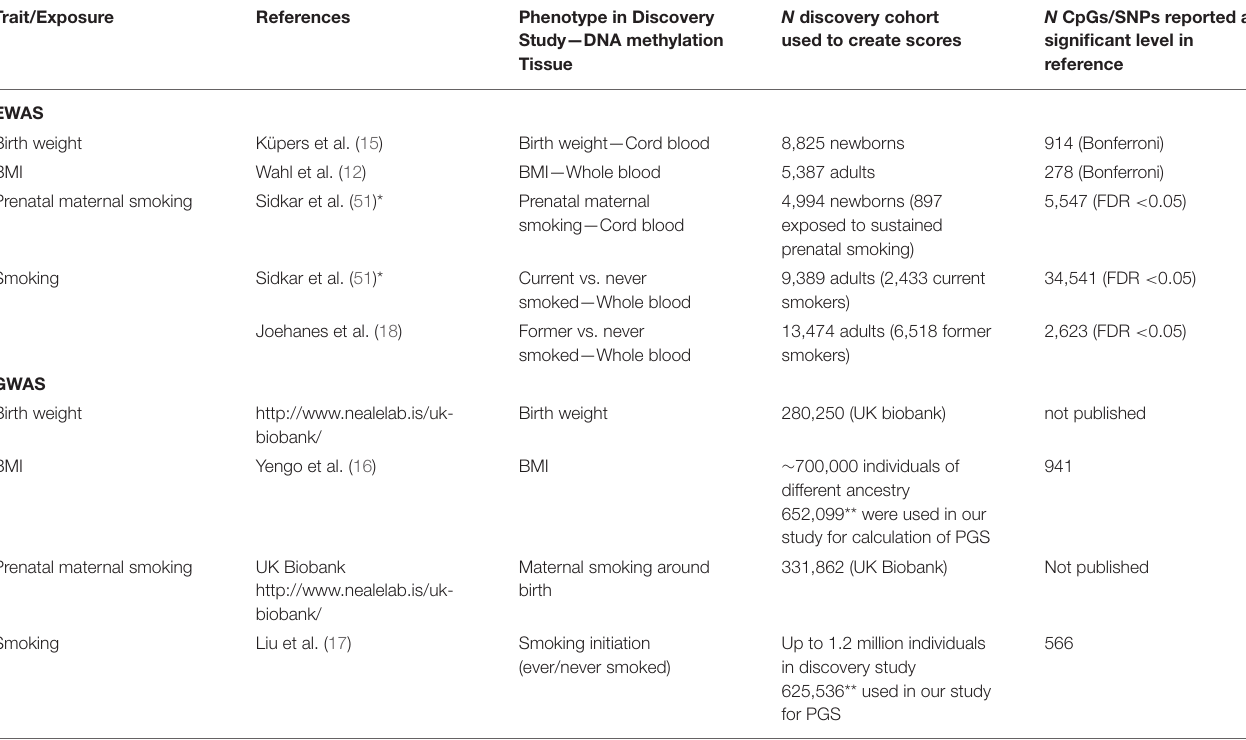
TABLE 1 | Discovery epigenome-wide and genome-wide association studies that provided the summary statistics to calculate DNA methylation scores and polygenic scores.